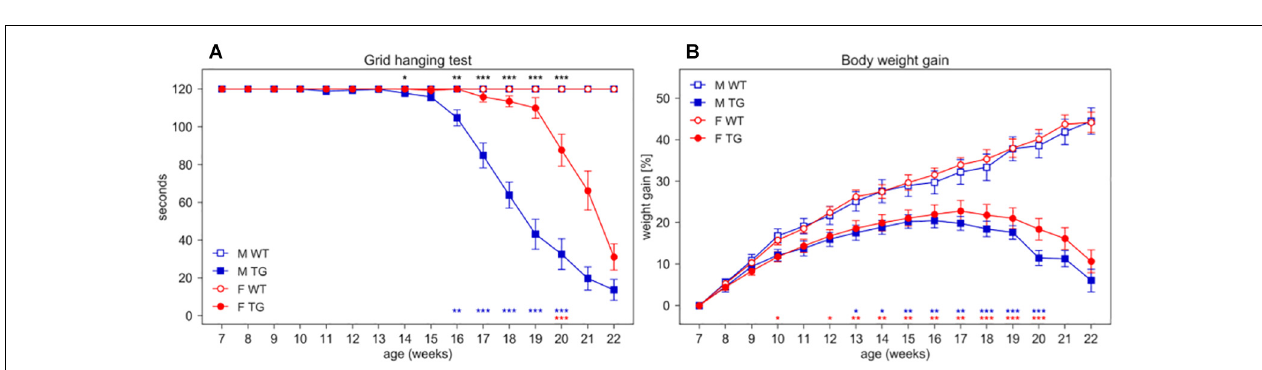
FIGURE 5 | Activity and RDI within the least active hour. Average weekly activity and RDI curves ( ± SEM) across 7–24 weeks of age in (A,C) males, (B,D) females, measured during the least active hour of the day. N of cages per group: M WT = 8; M TG = 9; F WT = 11; F TG = 10. In males (A,C) and females (B,D) * p < 0.05, ** p < 0.01, *** p < 0.001 WT vs. TG, D/AP post-hoc procedure.